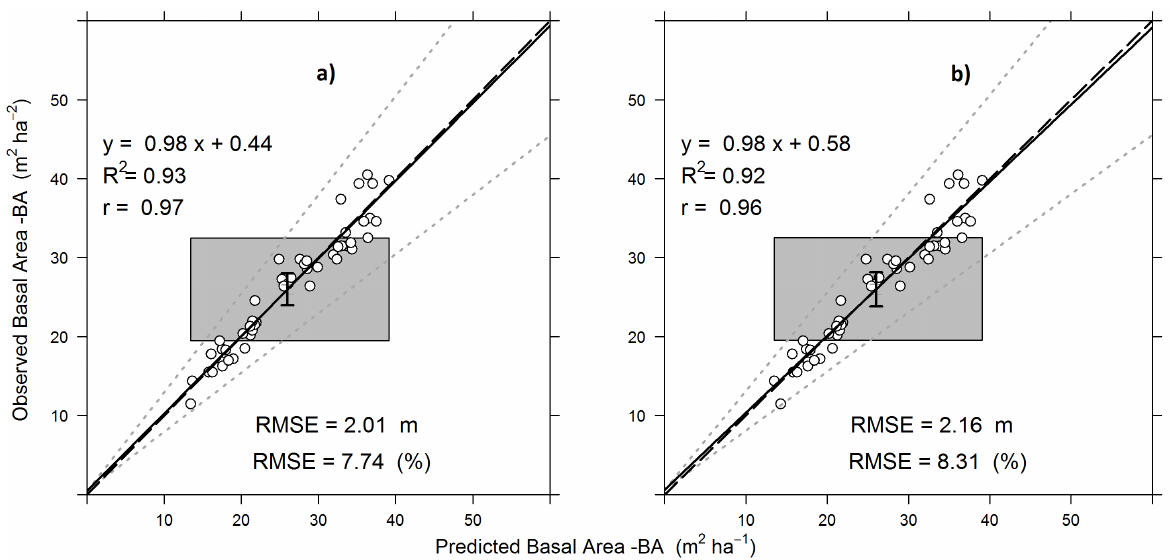
Figure 3 - a) Observed versus predicted BA (natural scale) from the adjusted model; b) Observed versus predicted BA from LOOCV; (n=50). The grey polygon represents the ± 25% region of equivalence for the intercept, and the black vertical bar represents a 95% of confidence interval for the intercept. The predicted BA from model and LOOCV are equivalents to the field- based BA for the intercept if the black vertical bar is completely within the grey polygon. If the grey polygon is lower than the black vertical bar, the predicted BA is biased low; and if it is higher than the black vertical bar, the predicted BA is biased high. The grey dashed line represents the ± 25% region of equivalence for the slope, and if the solid black line is contained completely within the grey dashed line, the pairwise measurements are equal. A bar that is wider than the region outlined by the grey dashed lines indicates highly variable predictions. The white dots are the pairwise measurements, and the solid black line is a best-fit linear model for the pairwise measurements. The black dashed line represented the relationship